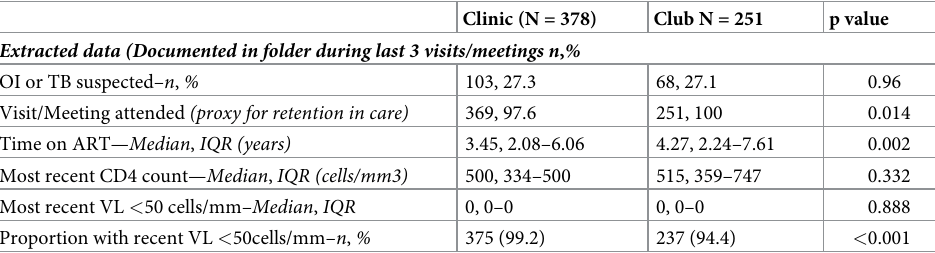
Table 5. Outcome of care: Client folder review. Extracted data (Documented in folder during last 3 visits/meetings n , %